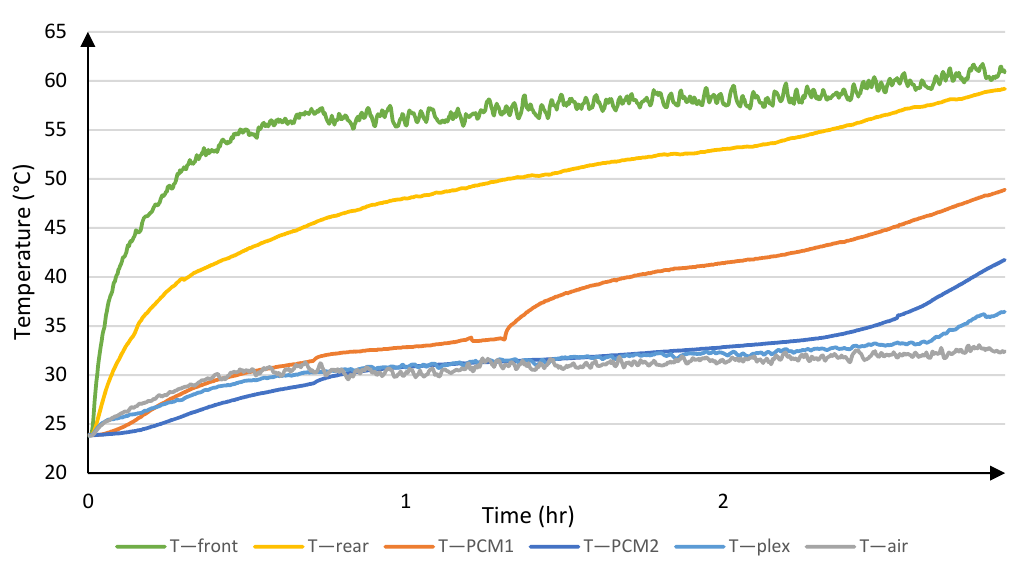
Figure 8. Monitoring of temperatures of the enhanced panel during the indoor test. Figure 9 visually shows the sequence of the same melting process.